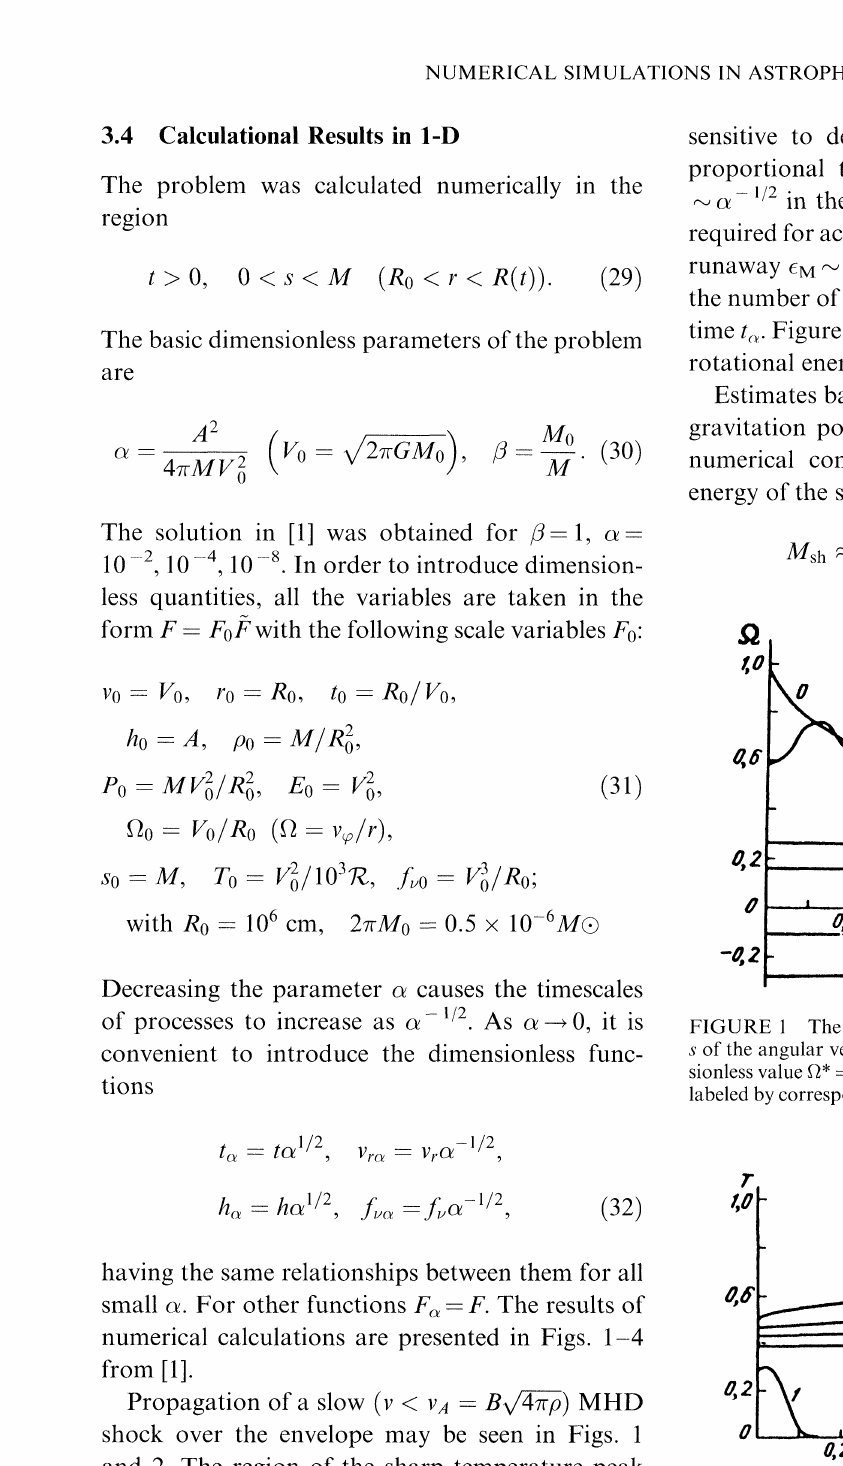
FIGURE 2 The distribution over the dimensionless parameter s of the temperature T normalized to the maximum dimension- less value T* =64.6 at various times for c, 0.01. All curves are labeled by corresponding times t, from